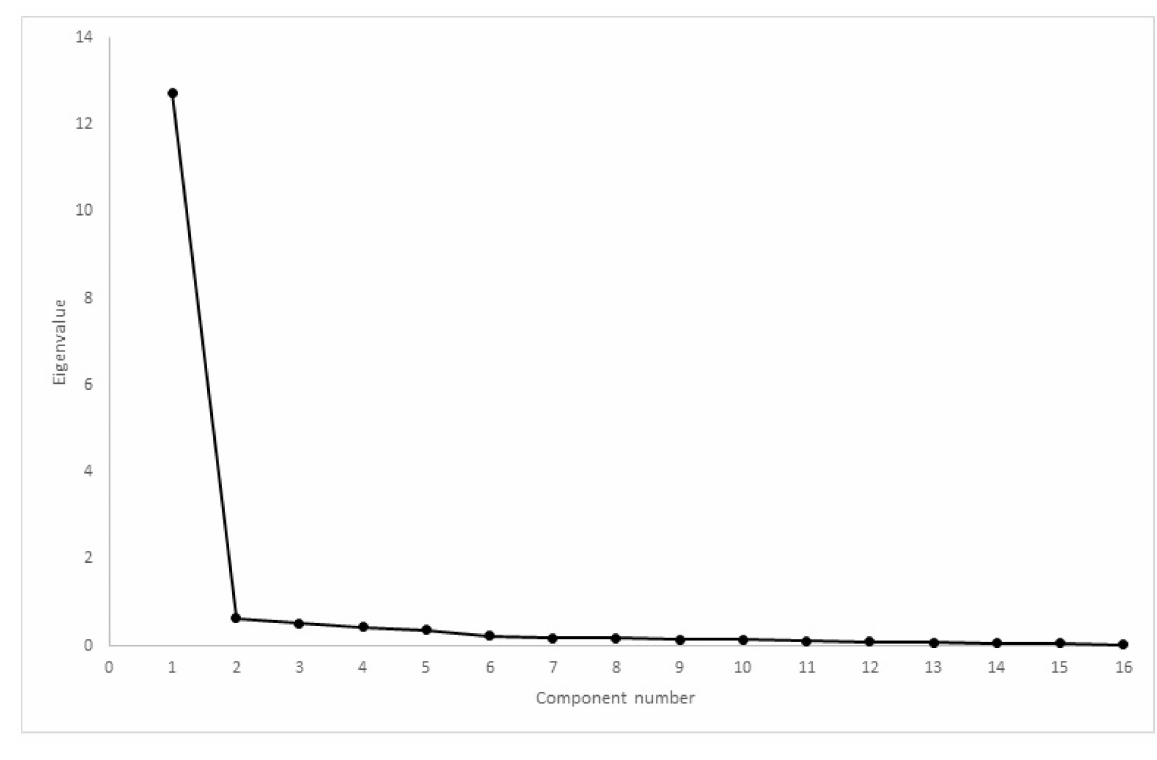
Figure 9. Scree plot of factor analysis of COI. One factor had eigenvalue >1, with a discernible “shoulder”